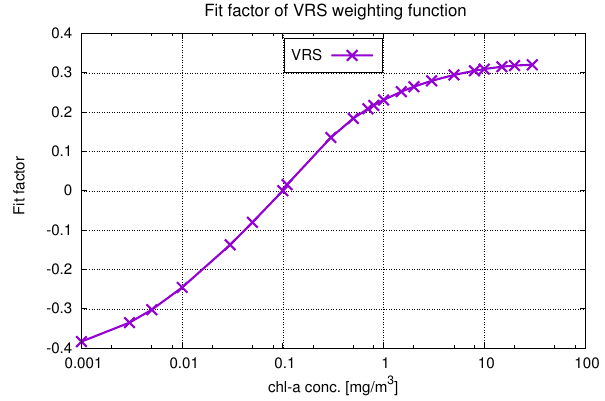
Figure 7. VRS fit factor (cid:49)q V of spectral fit results for the VRS weighting function from Fig. 6 as a function of chl a